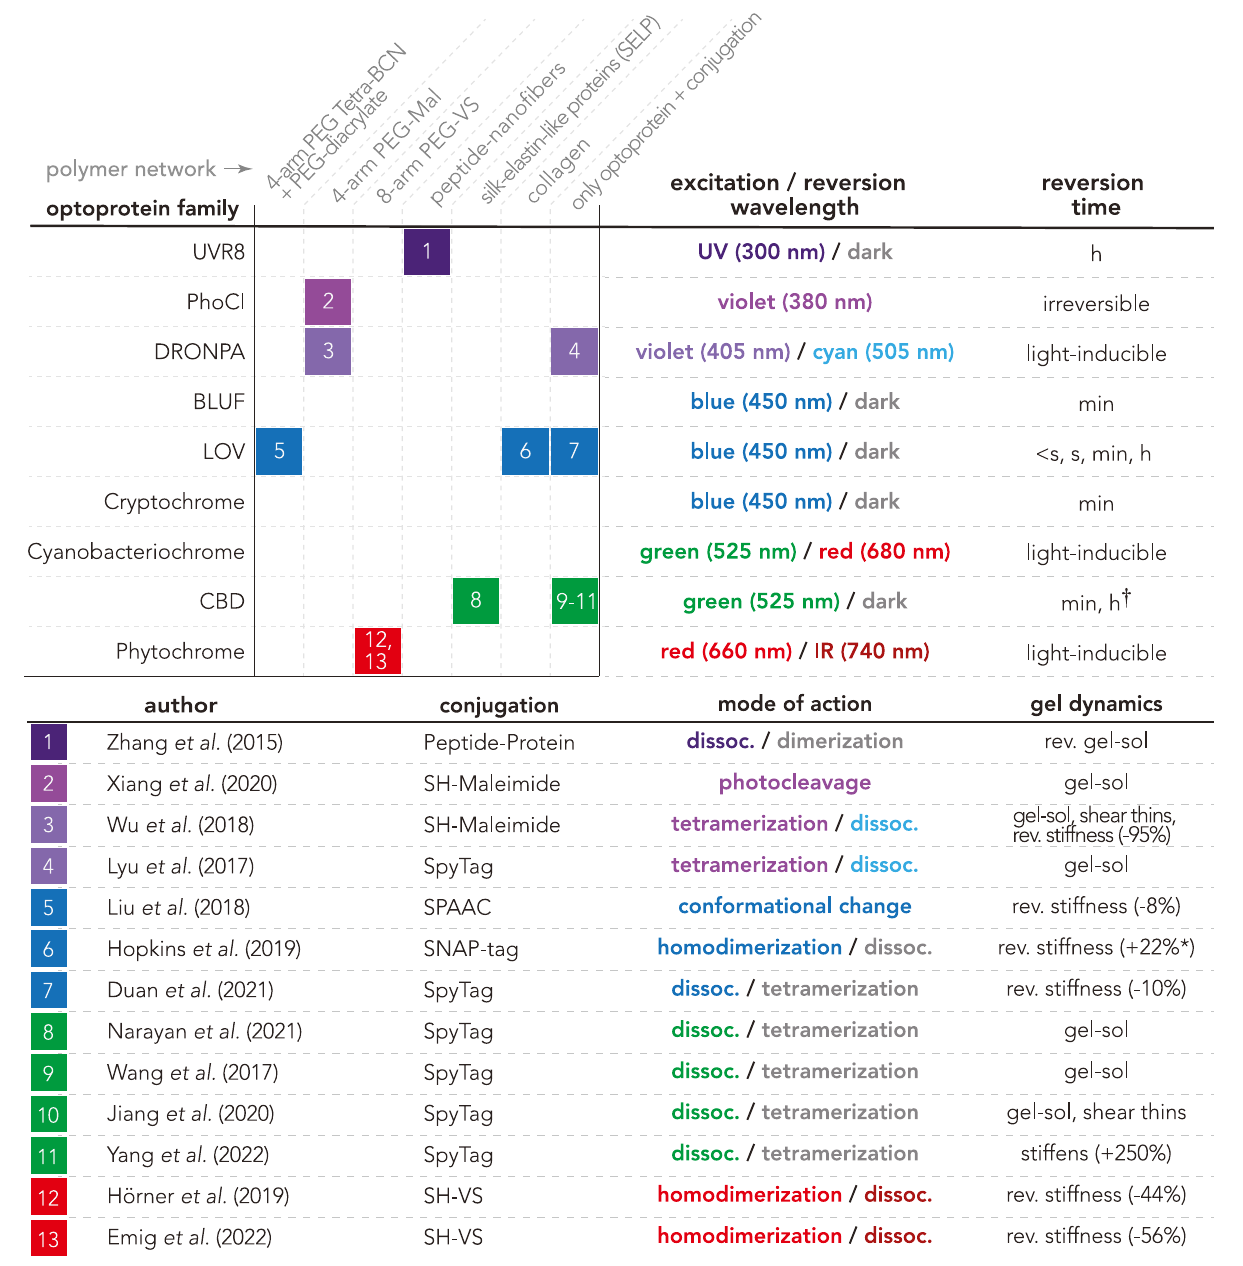
Frontiers in Bioengineering and Biotechnology |